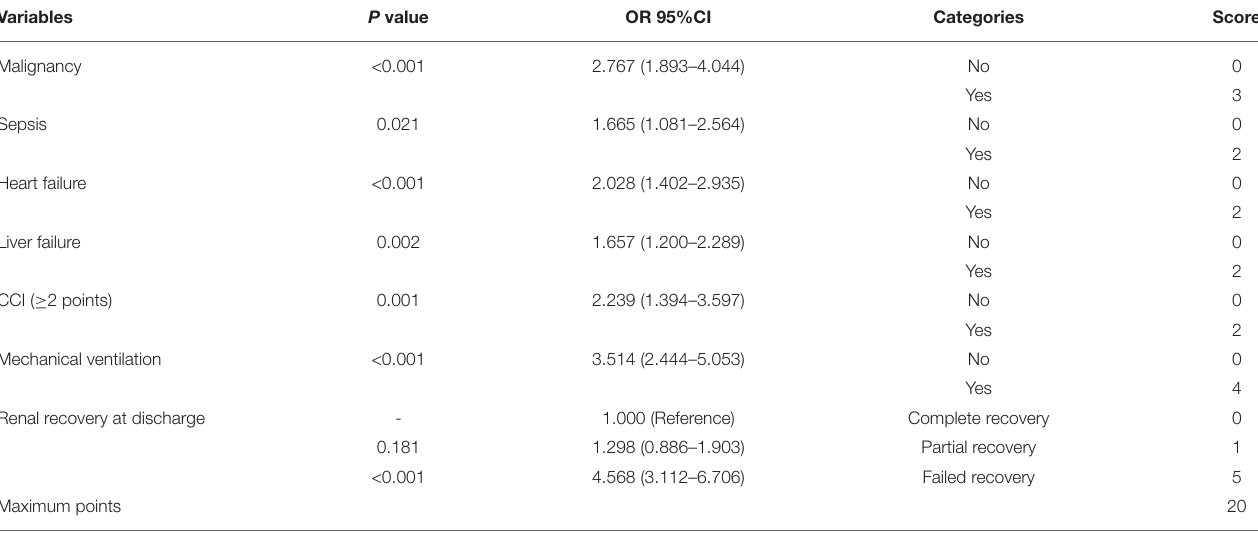
TABLE 6 | Predictors for 1-year mortality in the hospitalized ischemic AKI patients. Variables P value